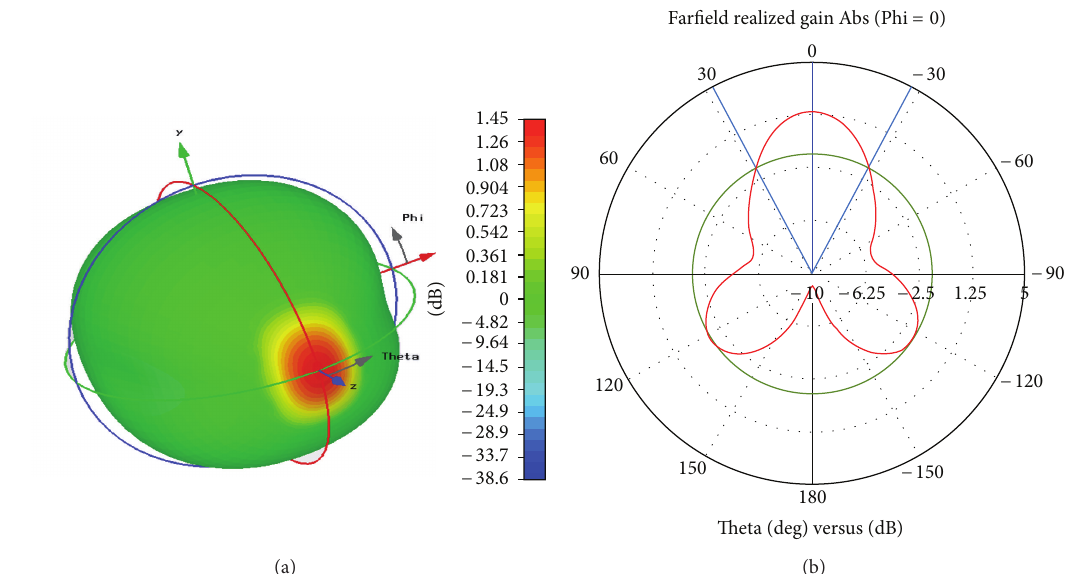
Figure 14: Radiation patterns of MCD antenna: (a) 3D pattern and (b) 2D elevation cut at phi = 0 ∘ .